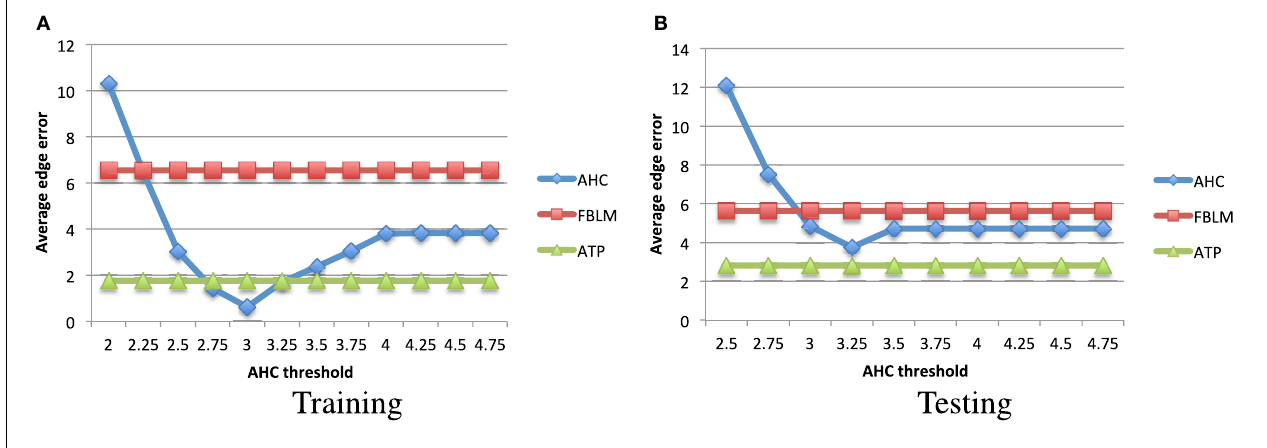
FIGURE 5 | The average edge error (Equation 4) vs. the agglomerative hierarchical clustering threshold parameter, for the hierarchical clustering obtained using the (A) training set’s attribute annotations, and (B) attribute detectors applied to the testing set image instances.